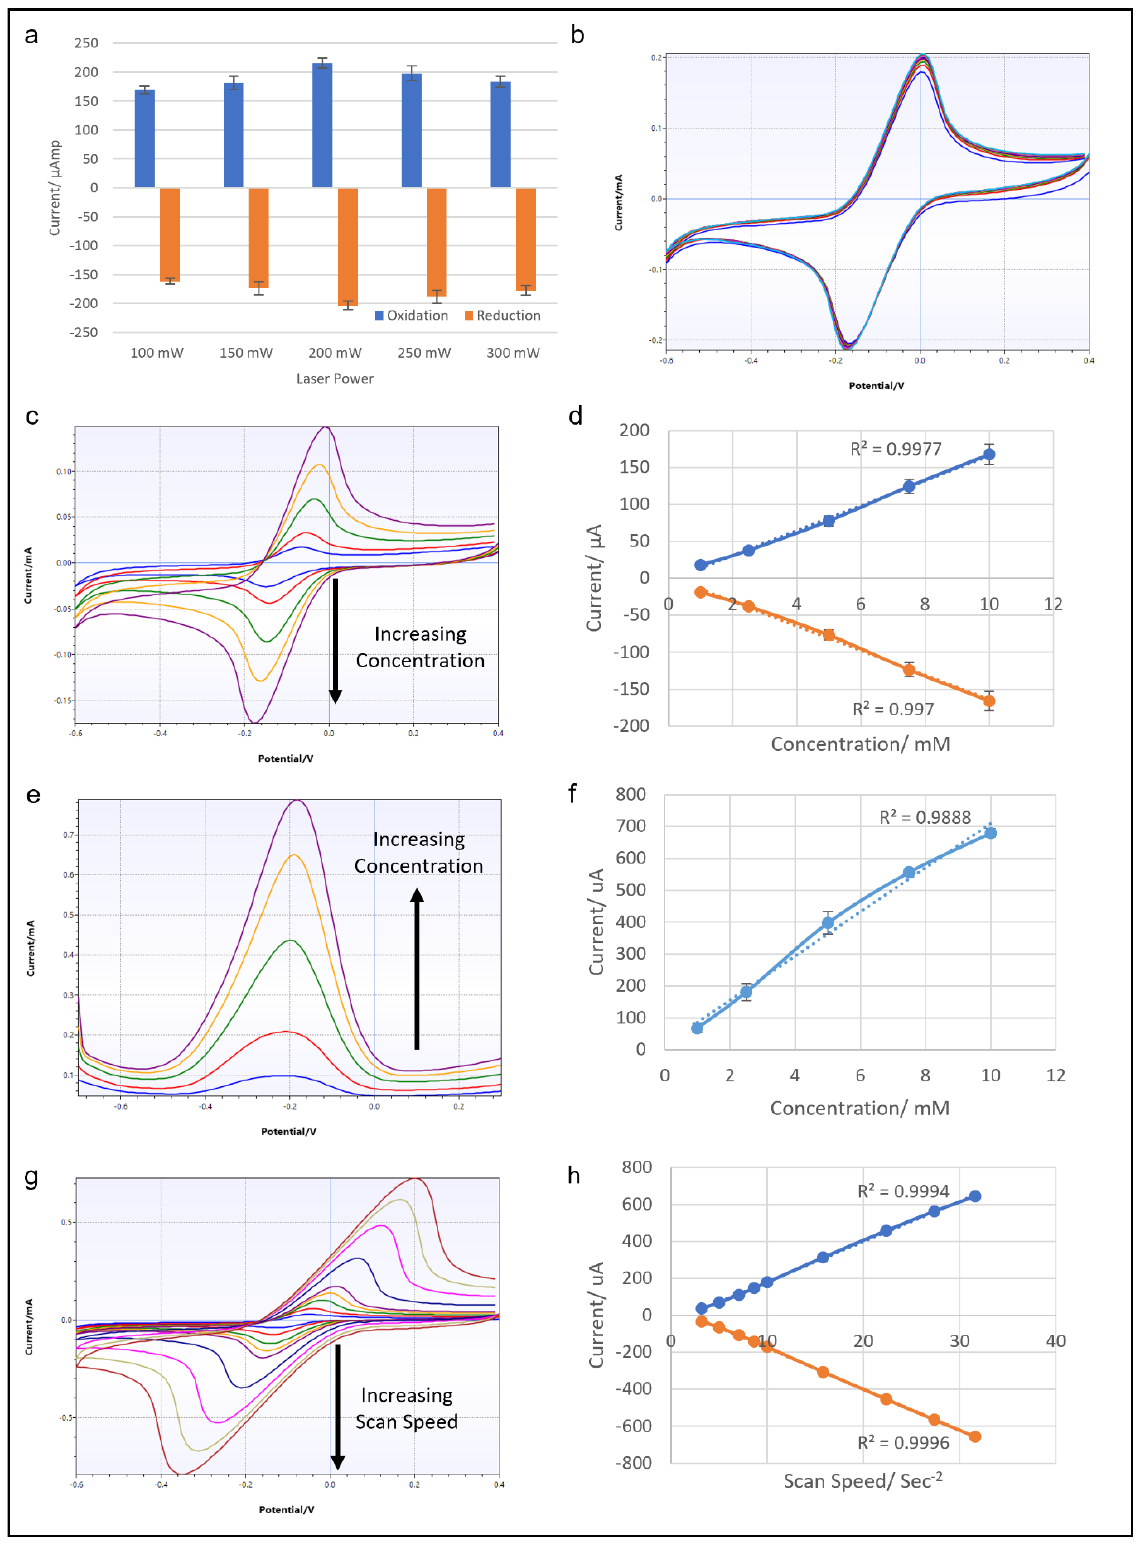
Figure 4. ( a ) Graph showing the results of CV from LIG electrodes fabricated by laser powers of 100, 150, 200, 250 and 300 mW at 100 mV/s scan rate. ( b ) Results of 10 cycles of CV with 10 mM ferricyanide with 100 mV/s scan rate from a LIG electrode made with a 200 mW laser. ( c ) CV traces of LIG electrode with ferricyanide concentrations of 1, 2.5, 5, 7.5 and 10 mM at 100 mV/s scan rate, and the corresponding graph relating the oxidation and reduction peak currents to ferricyanide concentration ( d ). ( e ) DPV traces of LIG electrode with ferricyanide concentrations of 1, 2.5, 5, 7.5